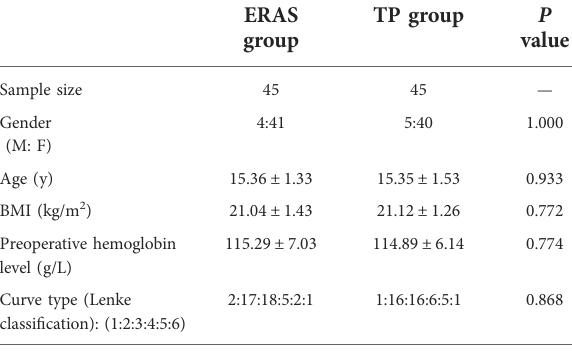
TABLE 2 Demographic characteristics.